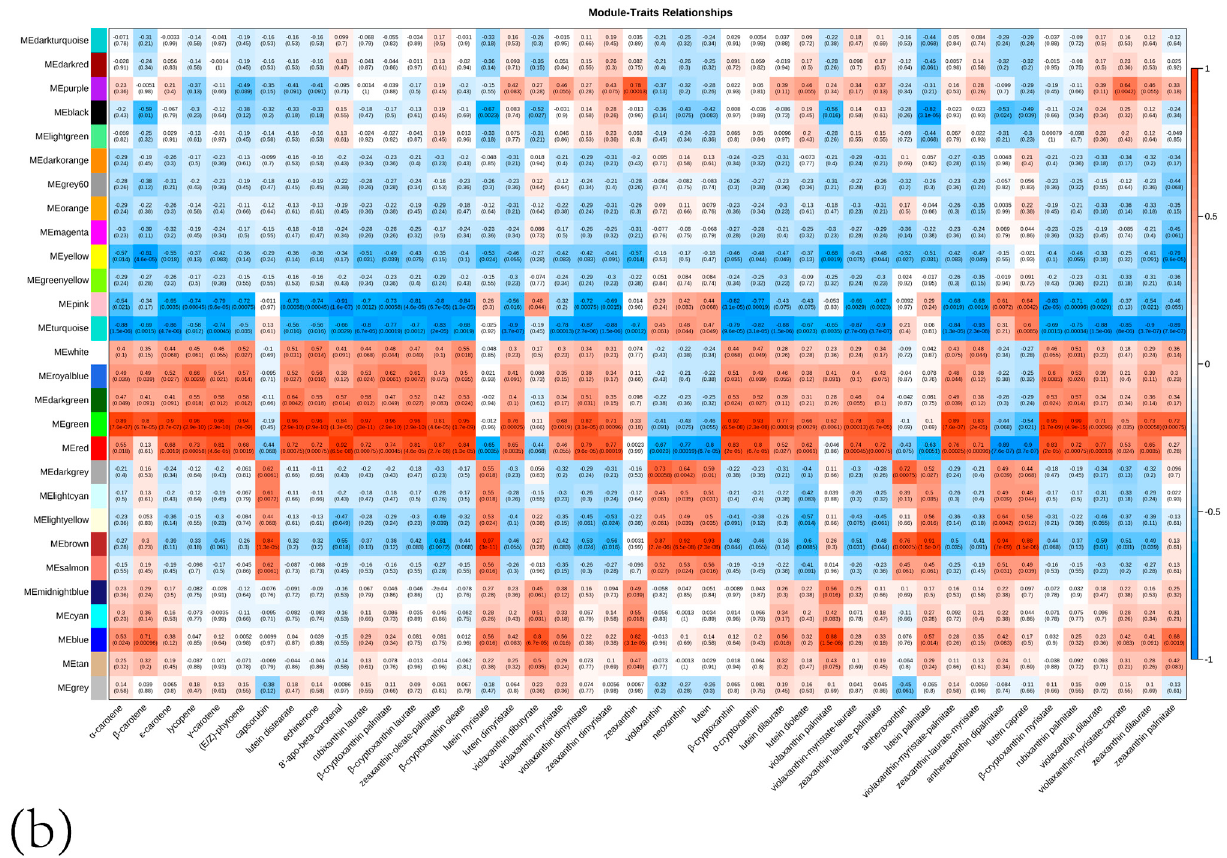
Figure 6. In total, 36,778 unigenes were subjected to weighted gene co-expression network analysis (WGCNA). ( a ) WGCNA co-expressed gene module hierarchical clustering tree (cluster dendrogram). ( b ) Each module’s carotenoid relationship and gene distribution are indicated. Each module-trait intersection is highlighted with the Pearson correlation coefficient and